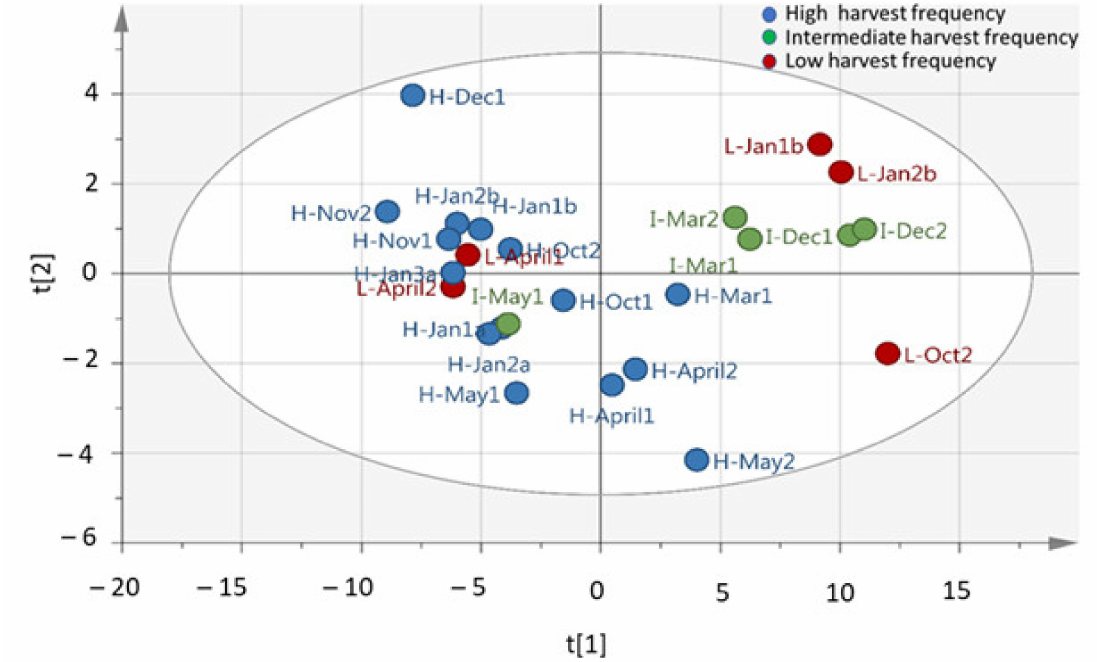
Figure 1. Principal component analysis (PCA) analysis (PC1 and PC2) of M. oleifera (cultivar PKM1) metabolite profile under high, intermediate, and low harvesting frequencies (R 2 X = 0.94; Q 2 = 0.844). R 2 X and Q 2 represent the cumulative values of all the components of the model. Low harvest frequency (red dots), intermediate harvest frequency (green dots), high harvest frequency (blue dots). H-30 days harvesting frequency; I-60 days harvesting frequency; L-90 days harvesting frequency; Jan-a = January, A = April, Mar = March, May = May, Oct = October, Nov = November, Dec = December; Jan-b–January of the next year. R 2 X[1] = 0.78; R 2 X[2] =